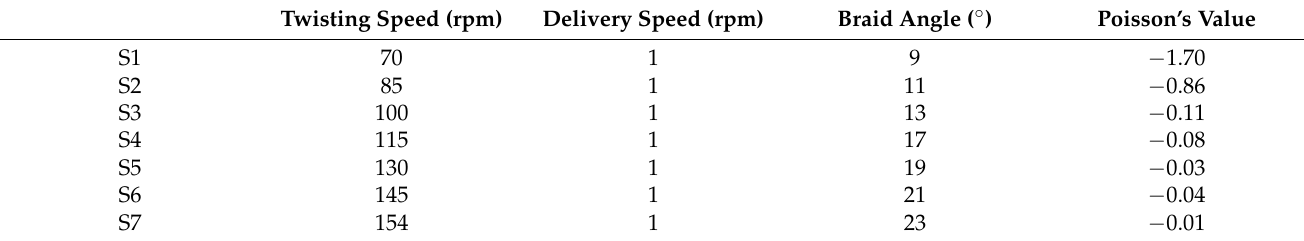
Table 1. Manufacturing parameters of auxetic yarn